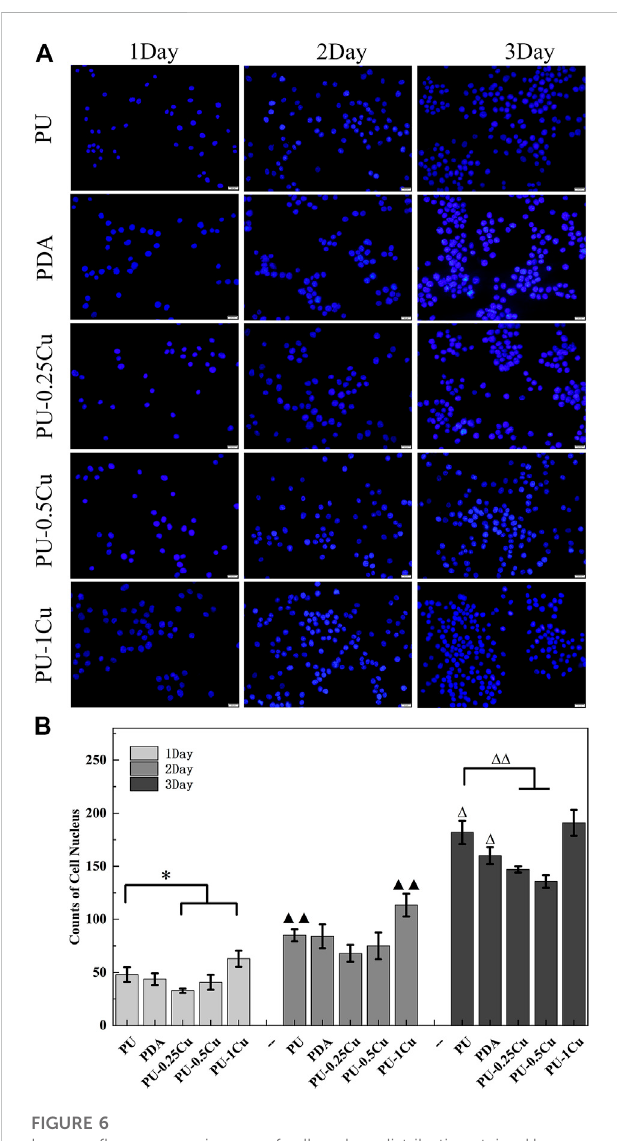
Immuno fl uorescenceimagesofcell nucleusdistribution stainedby DAPI. (A) Cell nucleus distribution imaged using Immuno fl uorescence microscopy. (B) The average quantities of the nucleus. Data were obtained from three randomareason each sample. The statistically signi fi cantdifferenceisshownas *p < 0.05 and Δ p < 0.05 .A verysigni fi cant difference is shown by ▲▲ p < 0.01 and ΔΔ p < 0.01